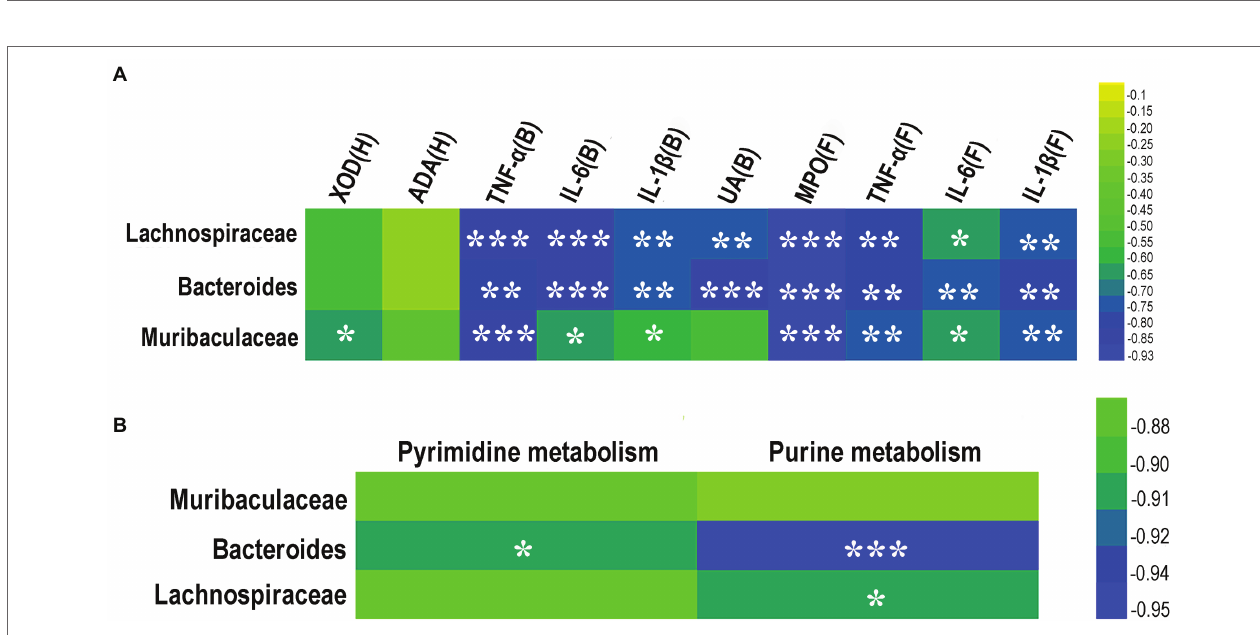
FIGURE 7 | Comparison of the relative abundance of the functional profiles of the gut microbiota based on PICRUSt among the five groups of mice. (A) Volcano plot analysis of altered Kyoto Encyclopedia of Genes and Genomes (KEGG) pathways with an average relative abundance >1% between the mice in CTL and Model groups. The p value is based on a two-tailed and paired t -test. (B) Distinct gene categories selected based on significant differences in gene categories at level 2 ( t -test, p < 0.05).